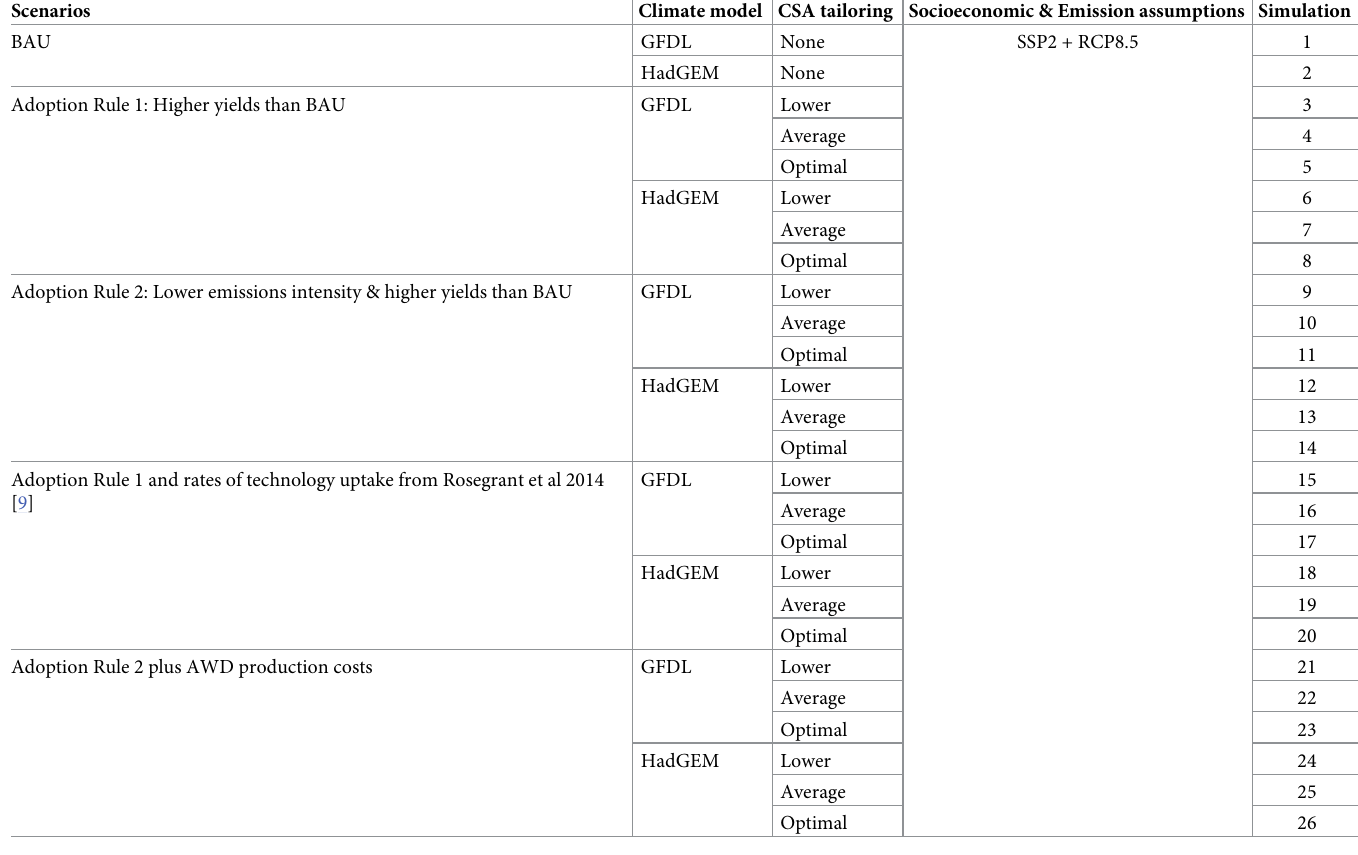
Table 2. Summary of scenarios